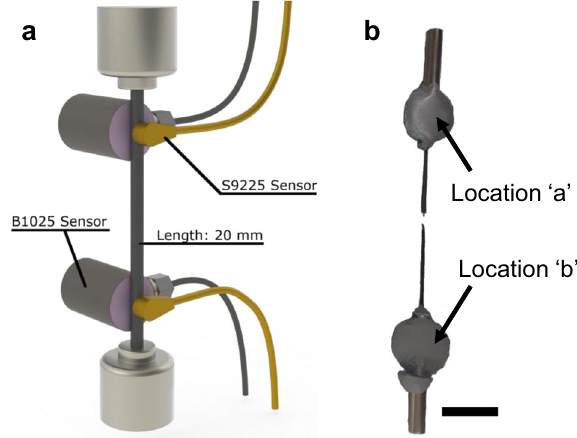
Fig. 1 Diagram of the experimental set-up. a Two sets of AE sensors were coupled to the minicomposite whose length is nominally 20 mm. When any sensor was triggered, all sensors began recording, ensuring that each AE event could be correlated between all sensors. b A photograph of a sample. Epoxy tabs used to mount AE sensors are denoted with arrows. Scale bar length is 10